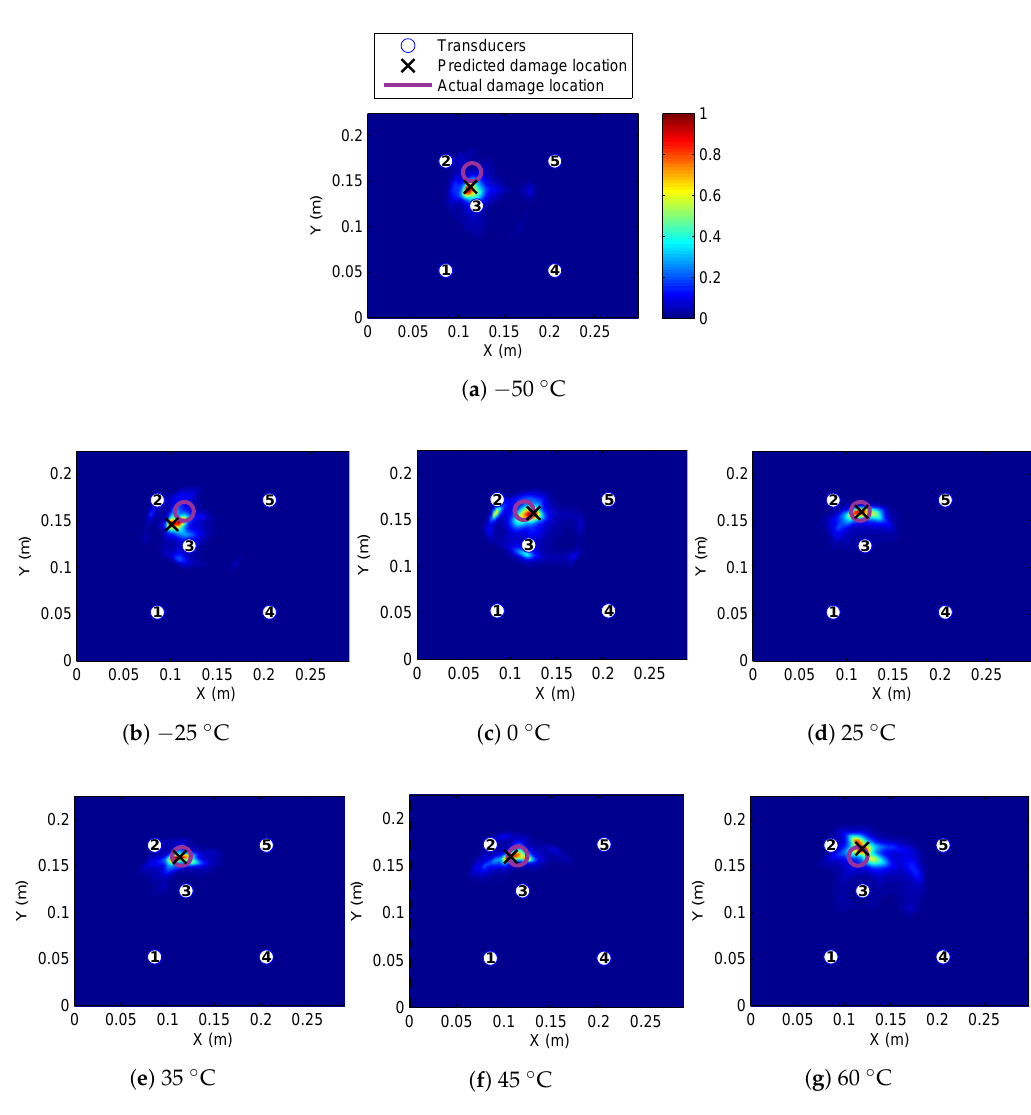
Figure 12. BVID localisation on the SHM layer CFRP plate at 50 kHz, baseline at 25 ◦ C, with compensated current signal temperature recorded between − 50 ◦ C and 60 ◦ C.